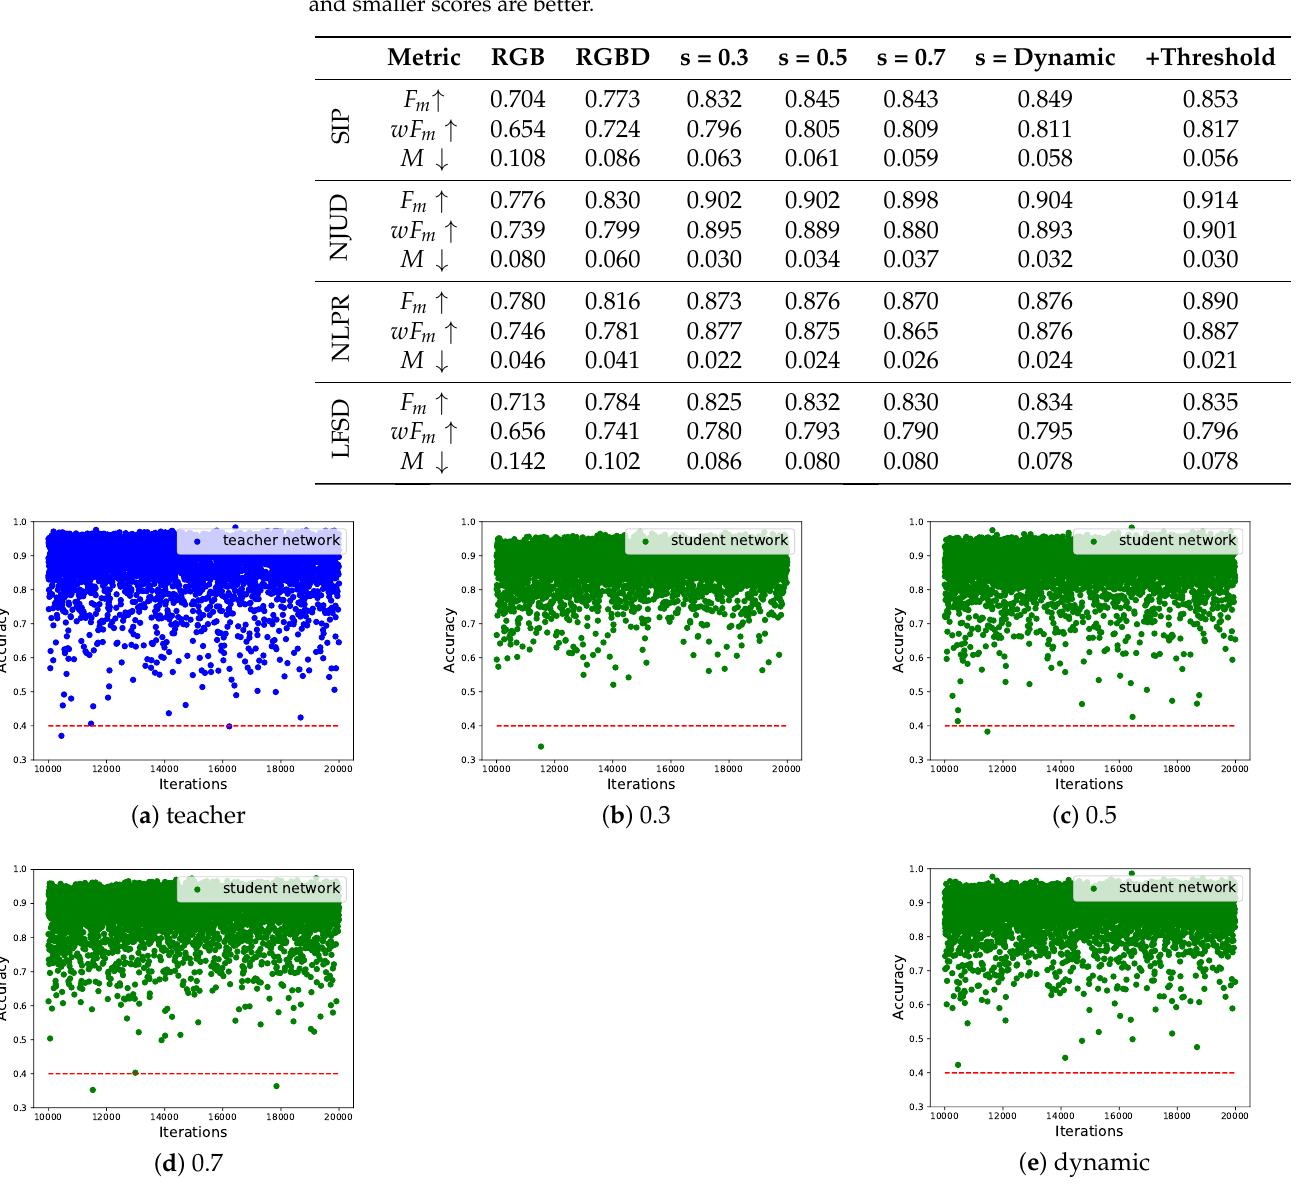
Table 3. Ablation analysis on 4 datasets. RGB and RGBD indicate that the student network is trained without/with depth maps, respectively, by cross-entropy loss. s indicates the weight of KD. Here we use the mean value of F-score F m and wF m to show the overall accuracy. ↑ and ↓ indicate that larger and smaller scores are better.